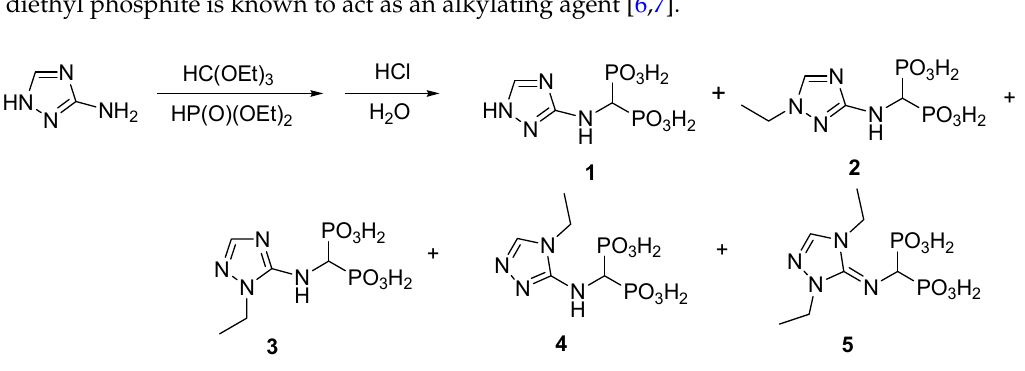
Figure 1. Reaction of 3-amino-1,2,4-triazole with tetraethyl orthoformate and diethyl phosphite.